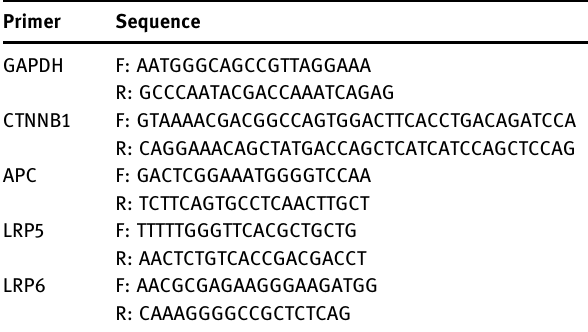
Figure 1: UV - Vis spectra showing absorbance peak of green - synthesized A. digitata AgNPs.